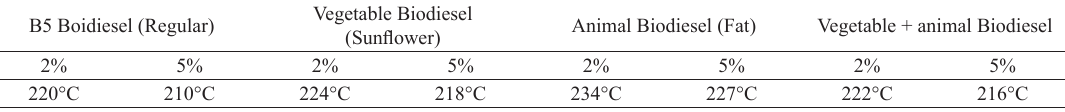
Table 4. Flash point values after contamination.